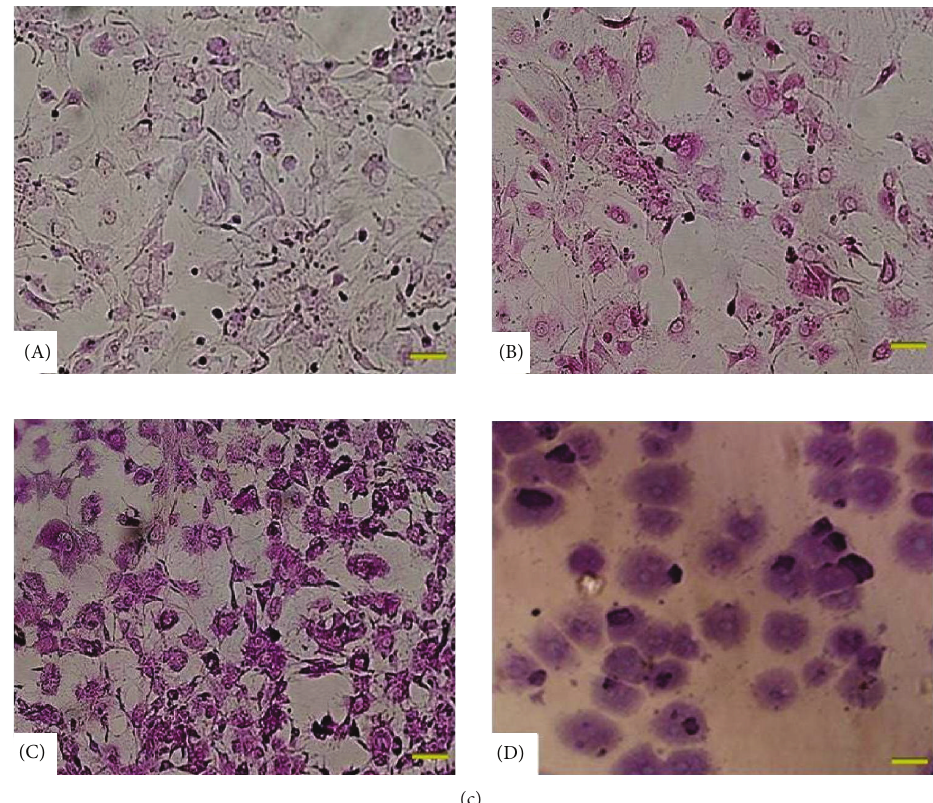
Figure 2: (a) Expression of hepatic markers: (A1) RT-PCR analysis of MSCs pretreated with cytokines (Lanes 1–5) 0, 7, 15, 21, and 28 days for the expression of Albumin , Cyt-8, and Cyt-18 . (Lane 6), mature hepatocytes were used as positive control. (A2) Gel band quantification by Image J software. (b) Immunocytochemistry of cytokines pretreated MSCs. (A–D) Expression of hepatic markers at protein level for Albumin , Cytokeratin 8, Cytokeratin 18, and AFP on day 15, respectively. Nuclei were counterstained with DAPI (blue) (200x, scale bar ∼ 100 𝜇 m). (c) PAS staining after pretreatment for glycogen storage: (A, B, C) PAS staining of cytokines pretreated MSCs on days 0, 15, and 21. (D) Mature hepatocytes as positive control (200x, scale bar ∼ 100 𝜇 m).